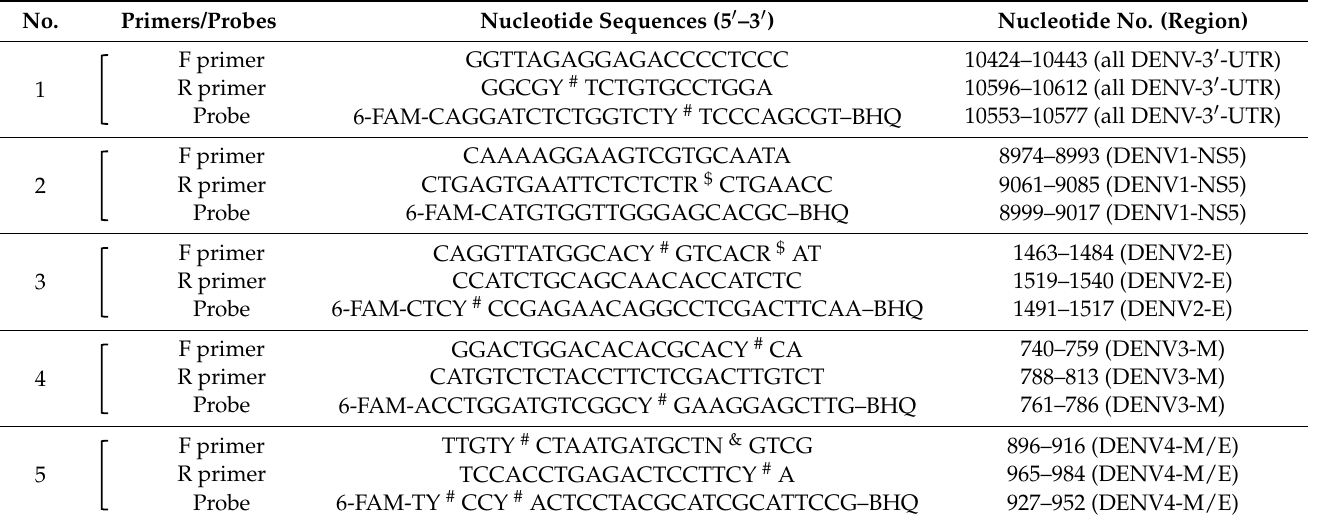
Table 2. Sequences of oligonucleotide primers and fluorogenic probes used in this study.